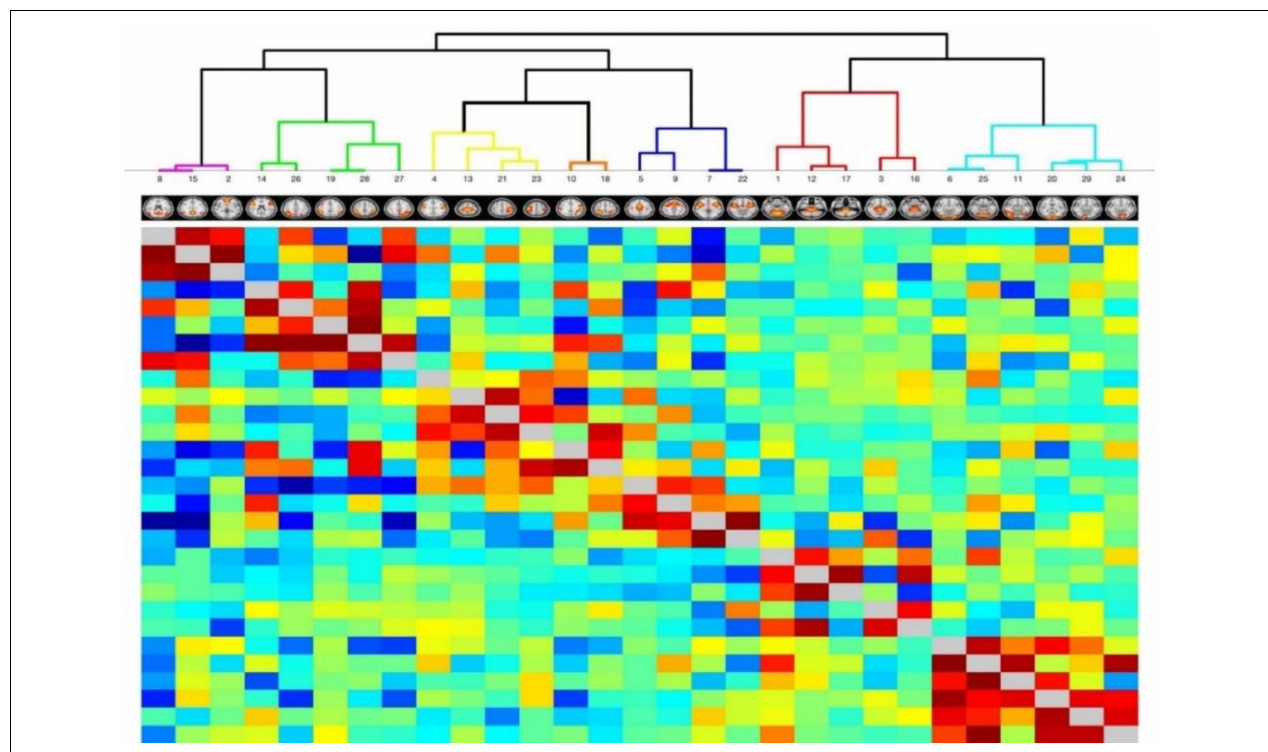
FIGURE 1 | Hierarchical clustering heatmaps. Time series data identified 29 nodes in seven resting state networks as independent components (IC) using templates in FSLnets. Heatmap overlay is red-blue, where red signifies positive and blue signifies negative correlations, respectively. Clade color corresponds to parent resting state network. Purple clade = Default Mode Network (DMN). Green clade = Frontal Parietal Network (FPN). Yellow clade = Sensorimotor Network (SMN). Orange clade = Dorsal Attention Network (DAN). Blue clade = Salience Network (SAL). Red clade = Subcortical Network (SUB). Aqua clade = Visual Network (VIS). The insert figures show representative FSL probability maps to localize each